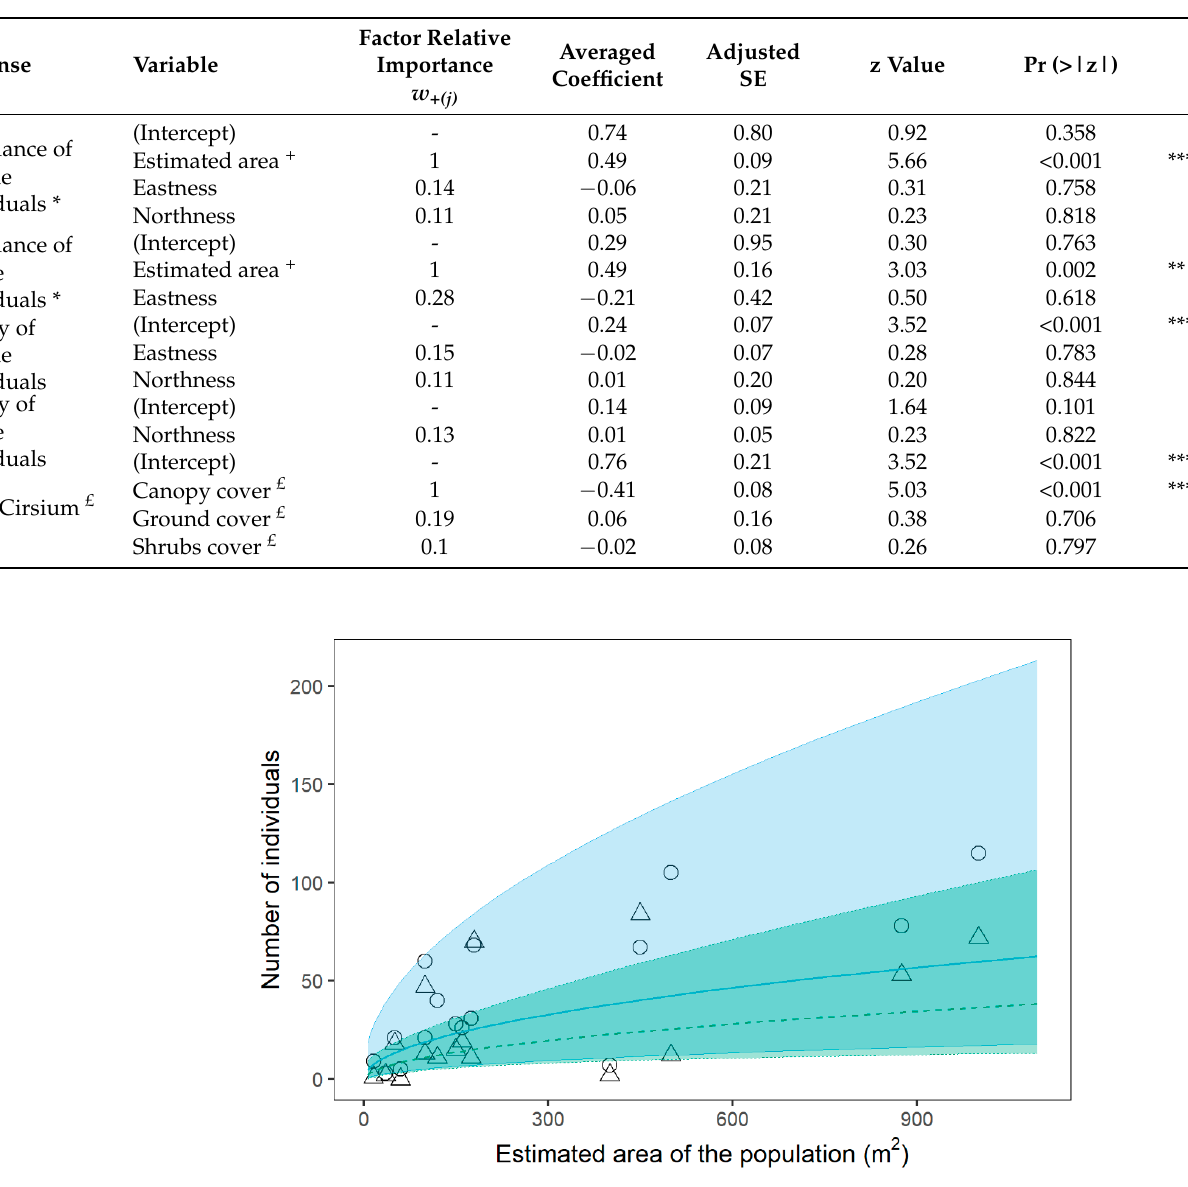
Figure 3. Relationship among number mature and juvenile individuals of Cirsium alpis-lunae and the estimated area occupied by the population. Regression lines and relative confidence intervals are calculated with the averaged coefficient following the multimodel inference in log–log spaces and back-transformed to linear scale to plot the actual numbers of the populations. Circles and solid lines = juvenile individuals; Tringles and dashed lines = mature individuals. Concerning the effect of the cover of the different vegetation layers on the cover of C. alpis-lunae at the subplot level, while all three factors were included in the best models, only canopy cover showed significant importance, thus resulting in the only factor actually affecting C. alpis-lunae (Table 2, see table S5 for model se- lection table). Indeed, canopy cover negatively affected the cover of C. alpis-lunae at the subplot level Table 2. The multimodelling on GLM on the factor affecting mature and juvenile individuals abun- dance and density, and on Cirsium alpis-lunae cover at the subplot level. Averaged coefficients are pro- vided only for factors included in the set of best models (see appendix for full model selection tables). A ( + ) marks the log-transformed variables in the following analyses, while a £ marks those transformed with an arcsin transformation. Significance codes: p < 0.001 = ***; p < 0.01 = **; p < 0.05 = *.